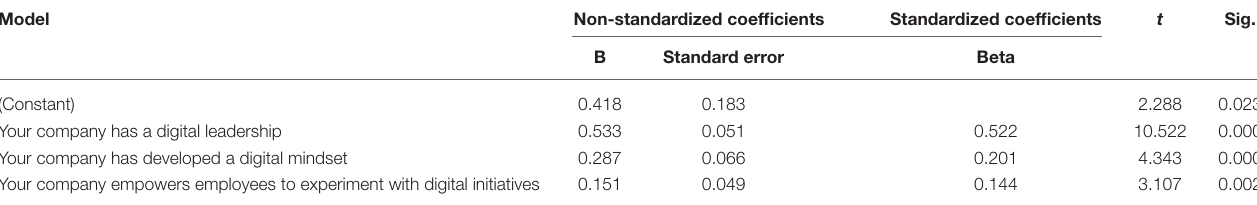
TABLE 2 | Regression model (coefficients and